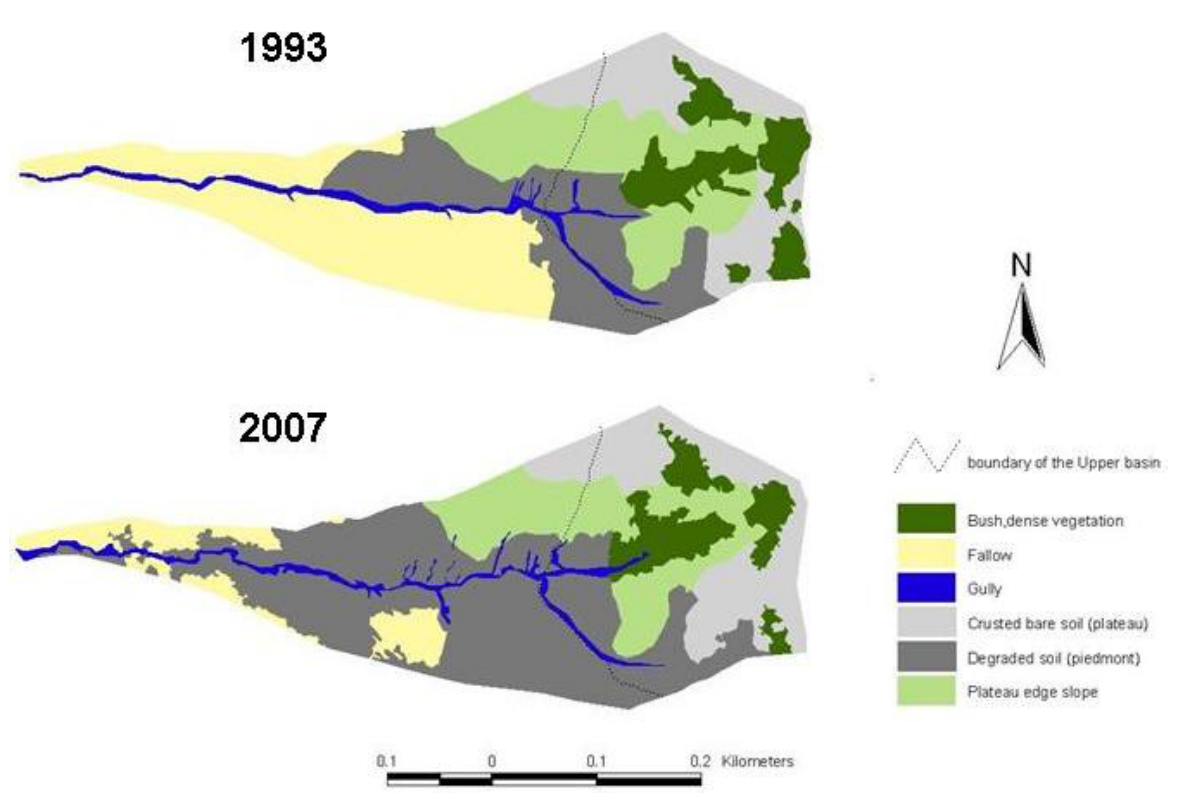
Table 3. Runoff coefficient in the Tondi Kiboro (TK) catchment between the two